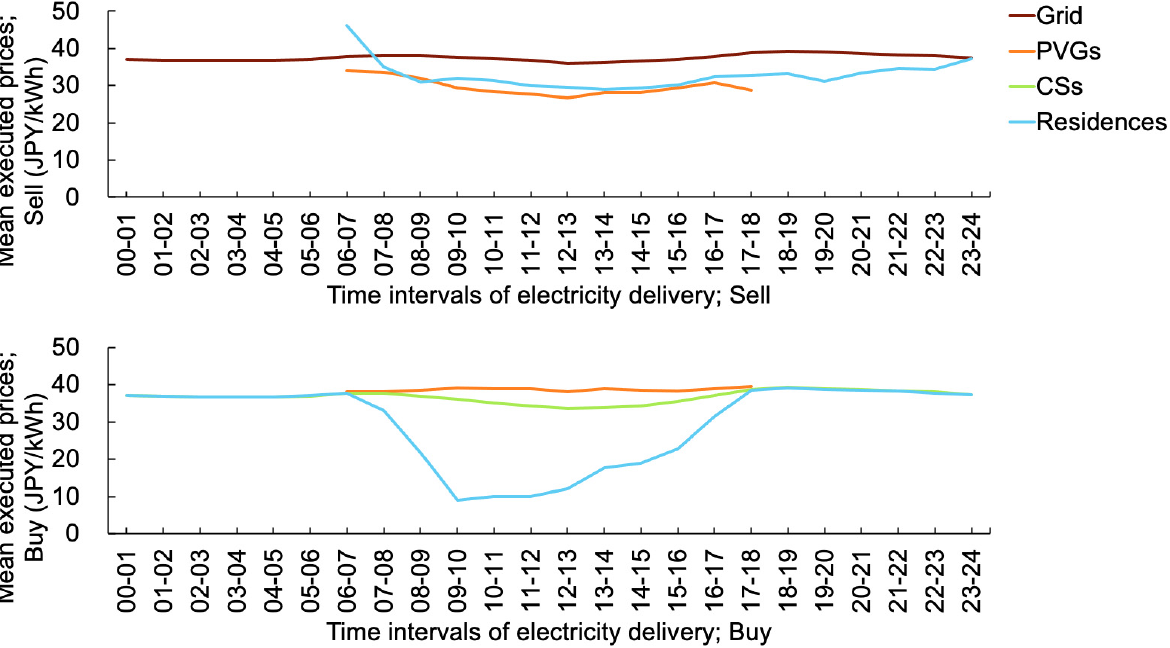
Figure 7. Mean executed prices for each time interval of electricity delivery in the target